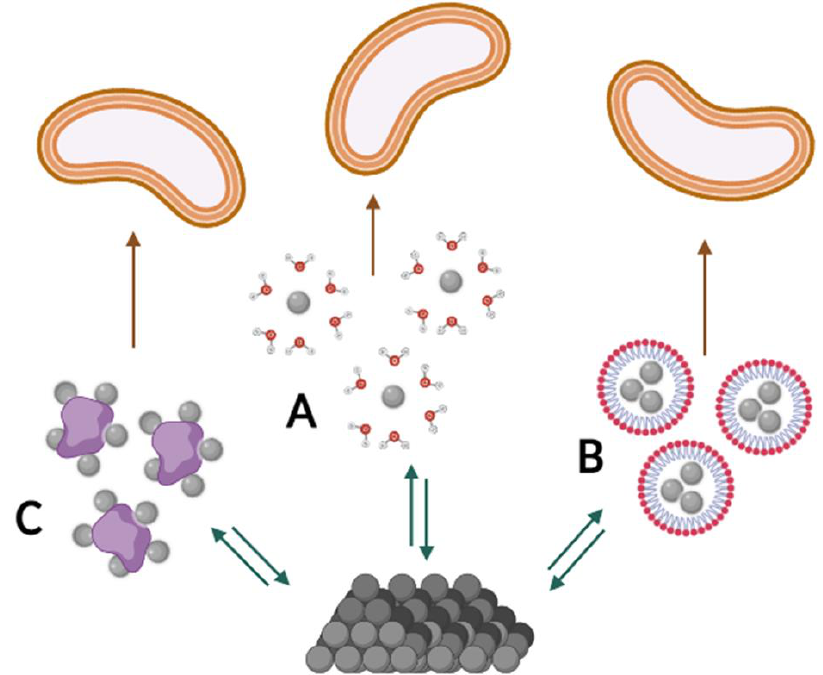
Molecules 2022 , 27 , x FOR PEER REVIEW Figure 3. Main strategies of increasing of bioavailability of organic compounds (grey circles) at the physicochemical level: ( A ) solubilisation; ( B ) transport in micelles; ( C ) transport on carriers.